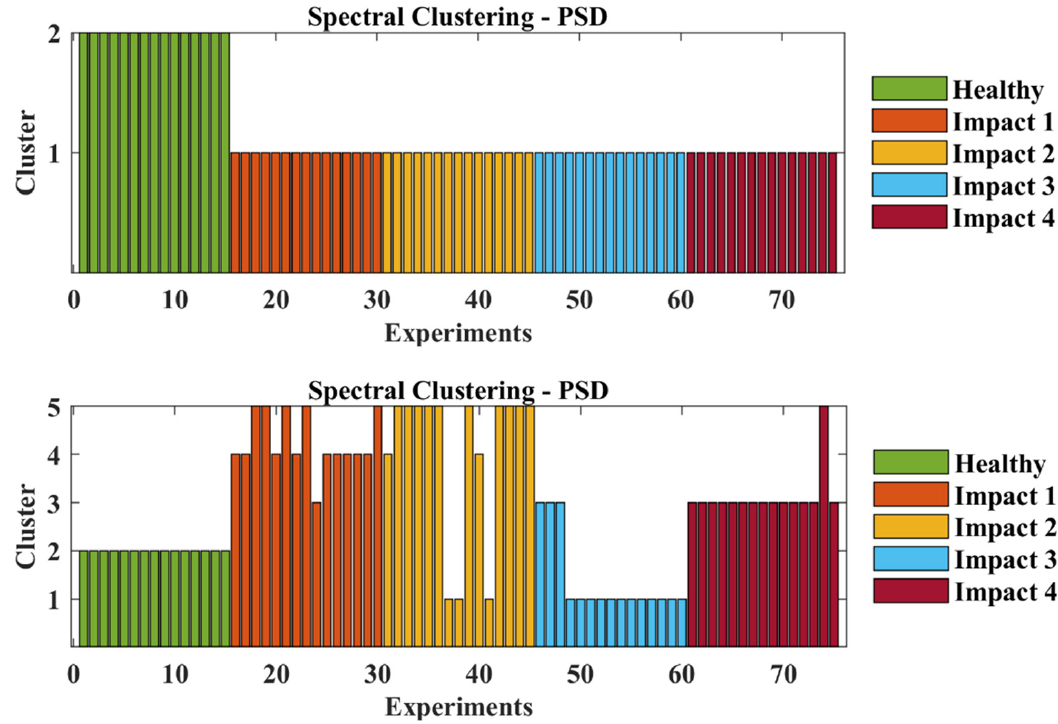
Figure 10. Spectral clustering using PSD. Input cluster = 2 ( up ), input cluster = 5 ( down ).